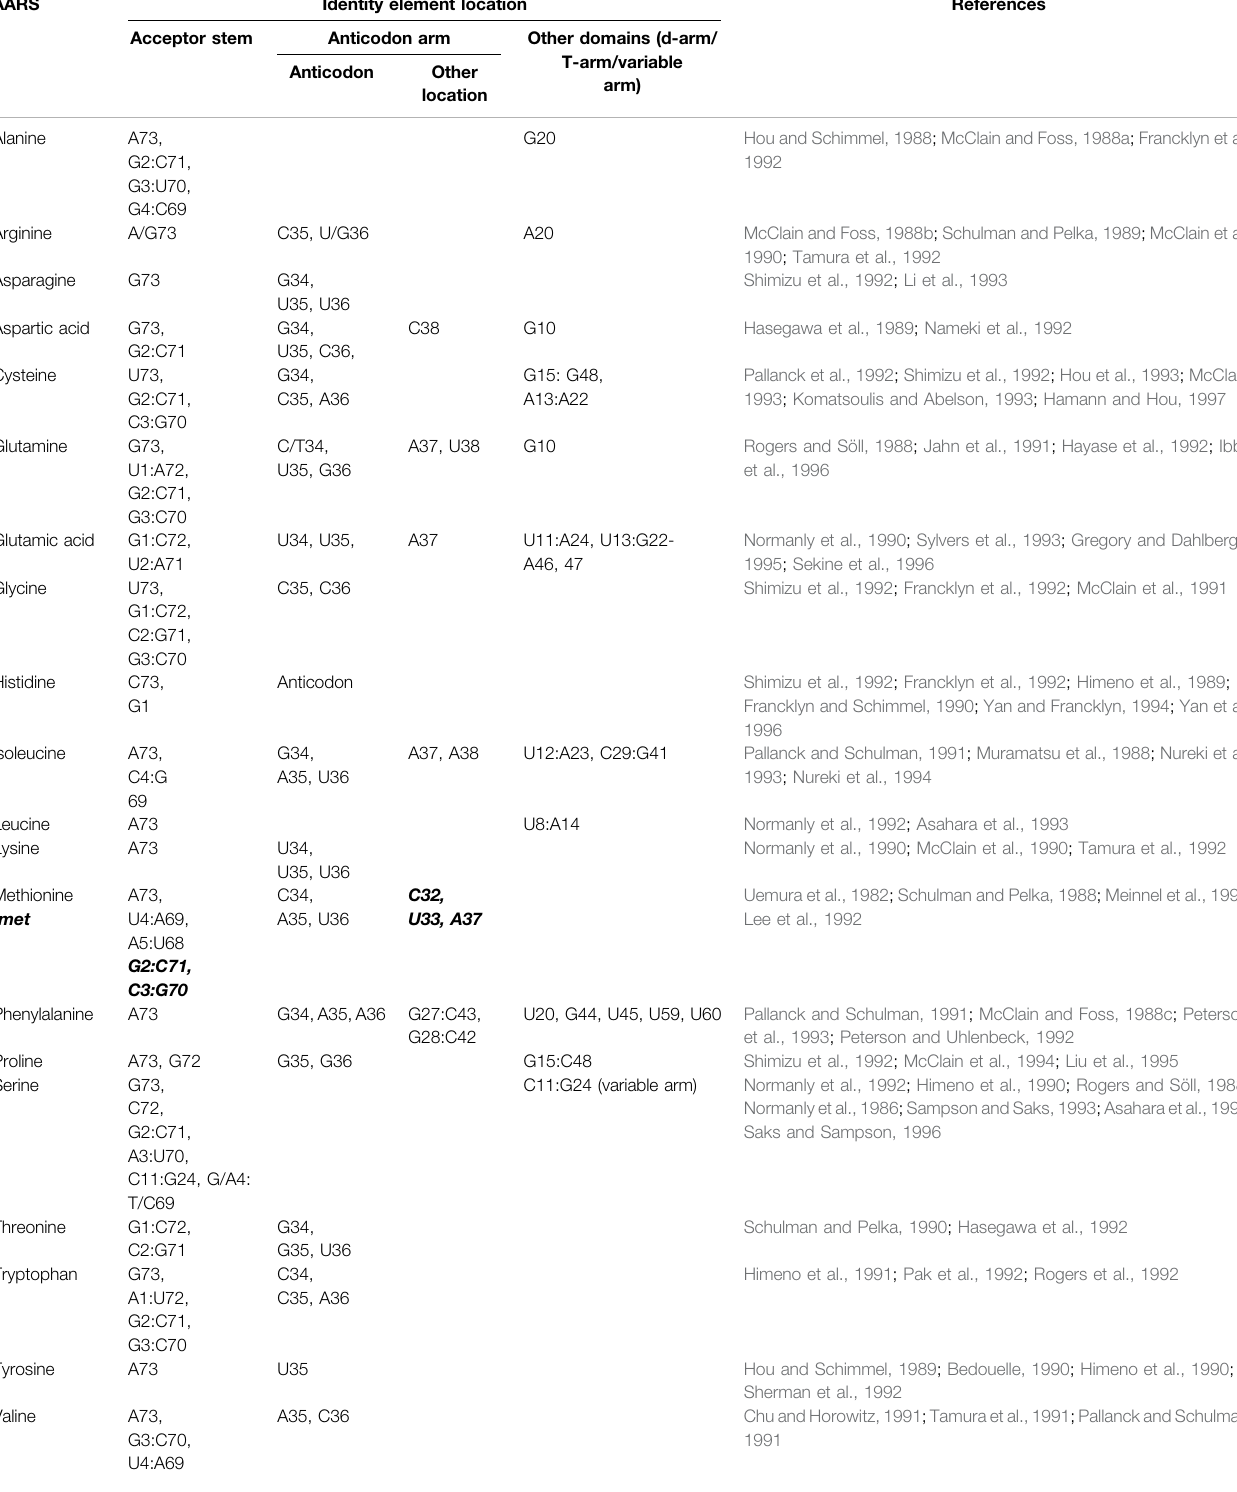
TABLE 1 | List of tRNA identity elements and their location on tRNA for aminoacylation by AARS from E. coli . Identity elements for fMet are provided in italics and bold.